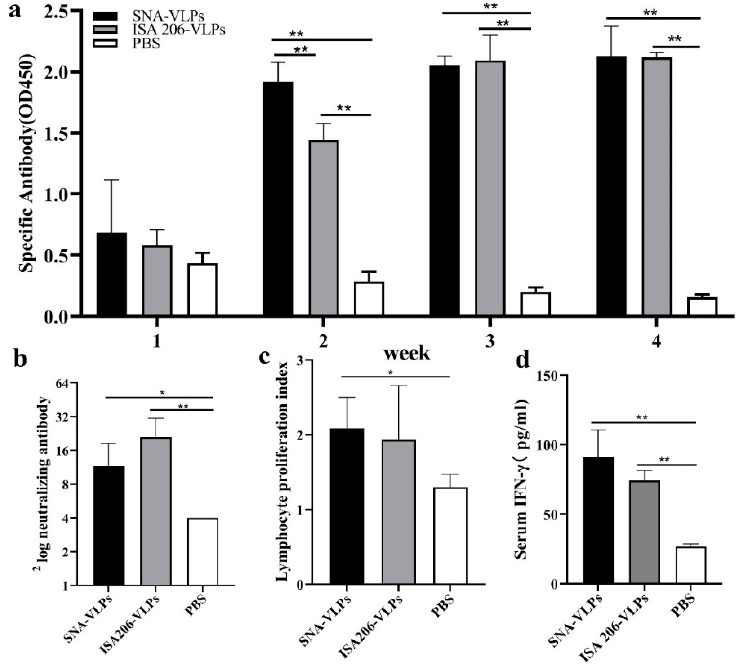
Figure 7. The results of the immunization experiments in guinea pigs. ( a ) The specific antibody lev- els in the guinea pigs immunized with various vaccines. ( b ) The levels of the neutralizing antibody. ( c ) The lymphocyte proliferation index. ( d ) The IFN- γ levels in serum. * p < 0.05, ** p < 0.01. Table 1. Protection of guinea pigs after challenge with FMDV. Group Guinea Pigs